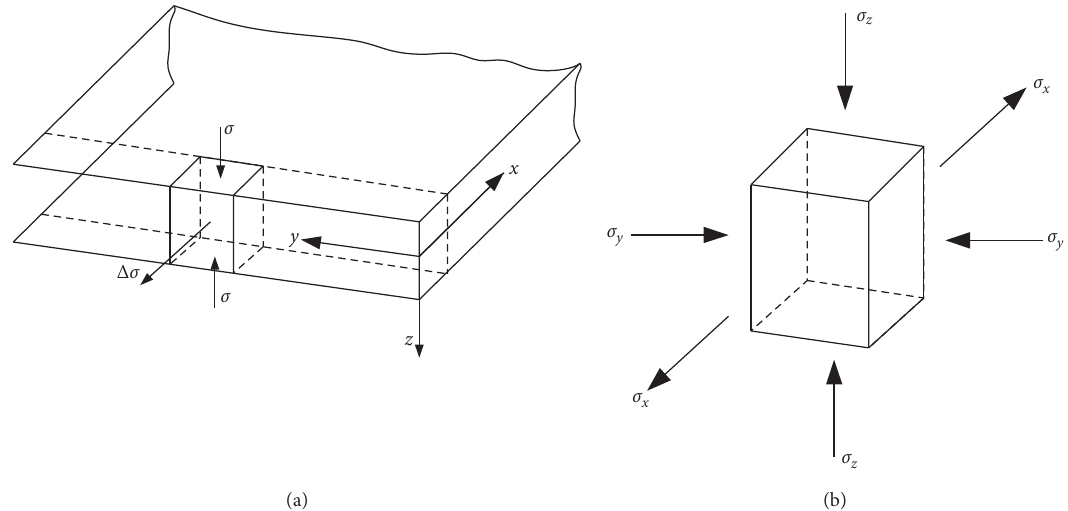
Figure 2: Unloading stress field in the coal body at the coal wall. Force diagram of the (a) coal body and (b) coal units at the coal wall on the working